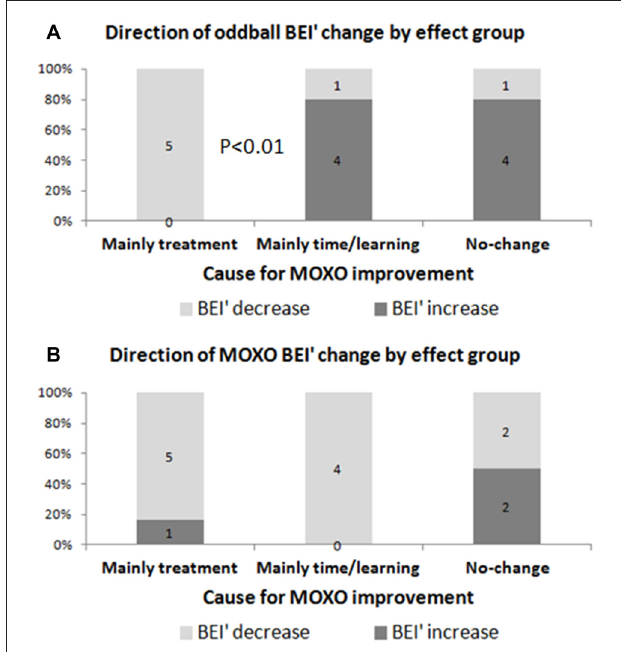
FIGURE 7 | Direction of BEI’ change as a function of main contribution to improvement in MOXO. Evaluation of BEI’ change according to the main contribution to improvement in MOXO: treatment (between MOXOs) vs. time/learning (within the first MOXO). (A) Oddball BEI’ in ADHD patients who were affected by treatment decreased (i.e., improved) after treatment, as opposed to participants who were affected by time/learning. (B) MOXO BEI’ showed similar decrease for both